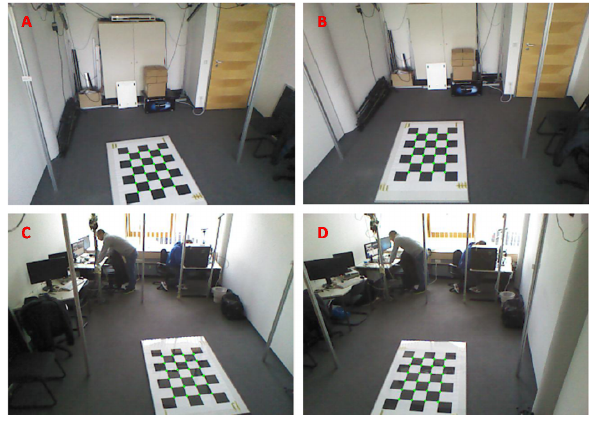
Figure 3: Optimized reprojected image points